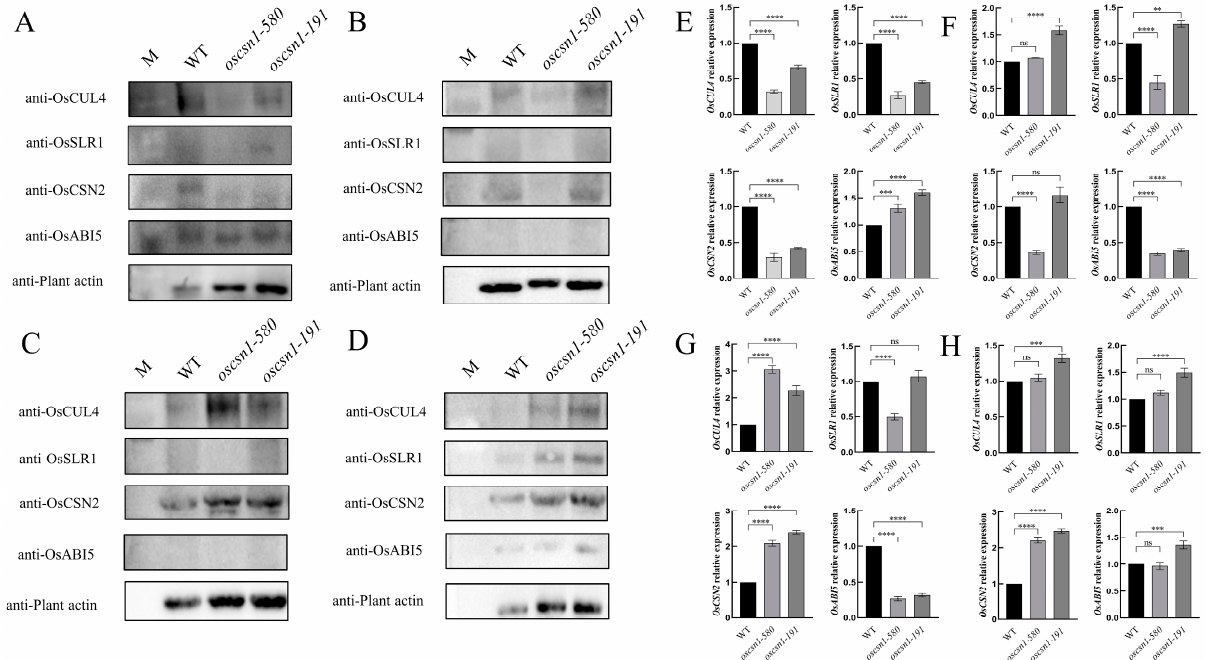
Figure 5. Expression protein and gene modification status in the oscsn1 mutants and the wild type under different light. Detection of proteins level in the wild type and oscsn1 mutants using a western blot. ( A ) Under light. ( B ) Under red light. ( C ) Under far-red light. ( D ) Under blue light. qRT-PCR analysis of the expression levels of gene in the wild type and oscsn1 mutants. ( E ) Under light. ( F ) Under red light. ( G ) Under far-red light. ( H ) Under blue light. The average values (± SD) from three biological repeats are shown. For each gene, different letters indicate significant differences in expression according to Duncan’s multiple range test, ** p < 0.01; *** p < 0.001; **** p < 0.0001; ns stands for no significant